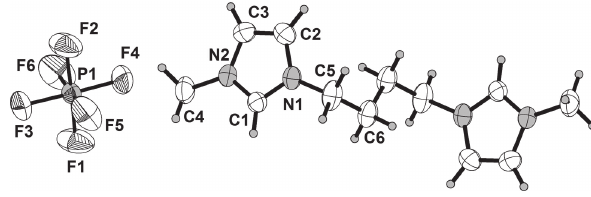
Table 1: Data collection and handling.